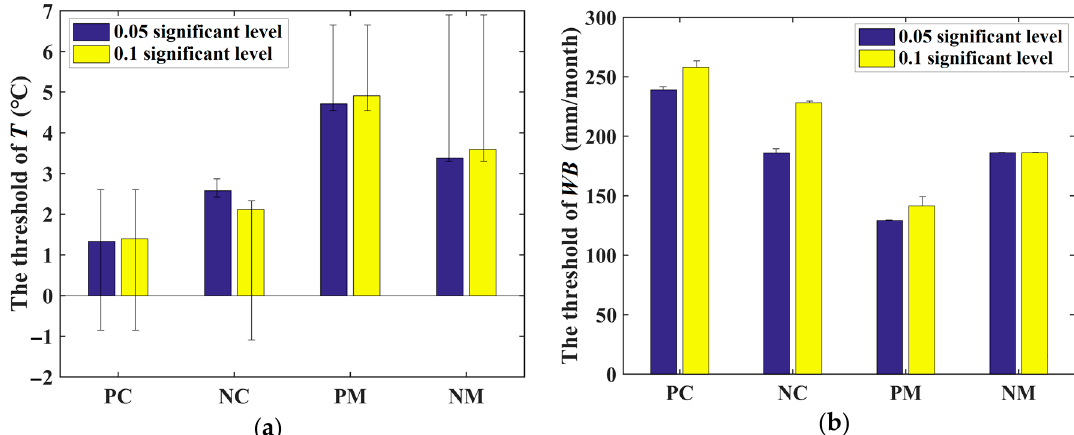
Figure 12. Comparison of ( a ) the temperature and ( b ) water balance thresholds between the statistically significant level of 0.05 and 0.1. The whiskers of the point are the actual value of T or WB around each threshold (detailed information can be found in Table S4); their value depended on the distribution of actual data of samples. The results considered 1–48 month time scales of water availability. The T threshold and WB threshold for a 0.1 significant level were acquired by the same method as that used for a 0.05 significant level, which was described in Section 2.3.